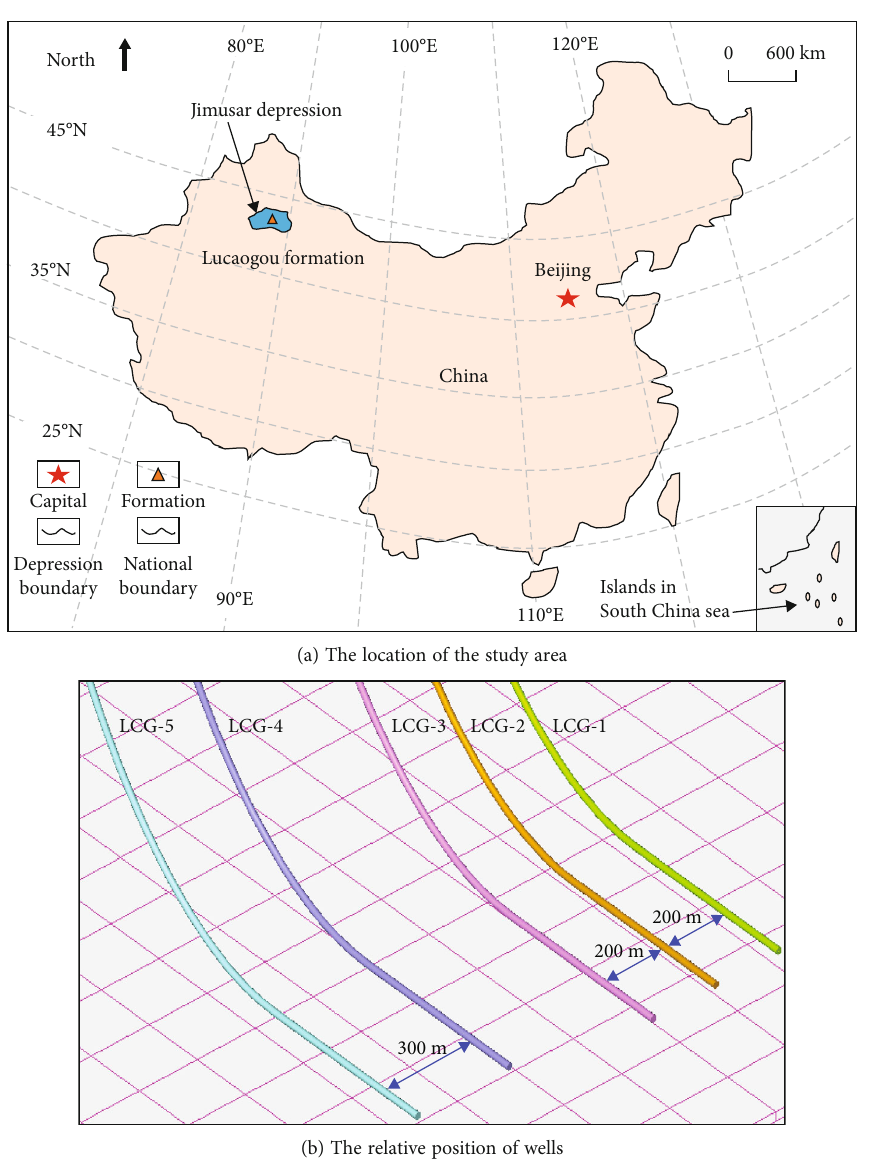
Figure 1: The description of study location and well relative position. Table 1: Well depth, length of horizontal segments, and fracturing